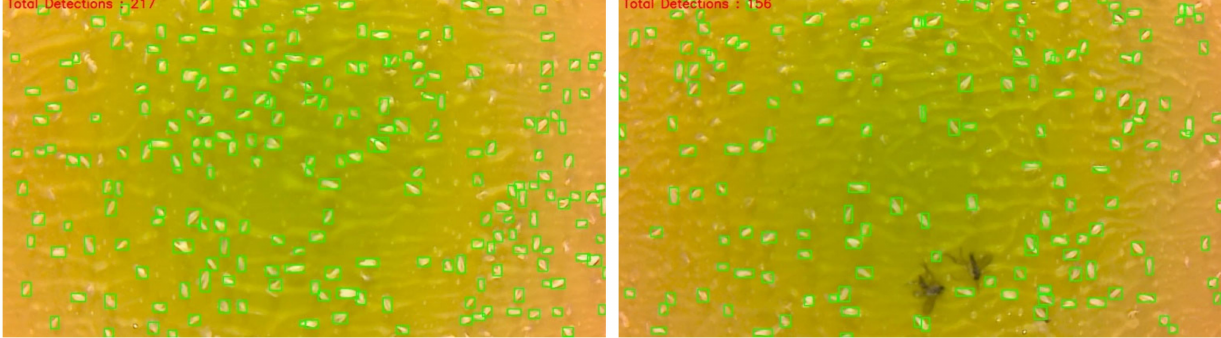
Figure 12. Two examples of detection results forFaster-RCNN model with negative training using yellow sticky tape image from web-RAID monitor.